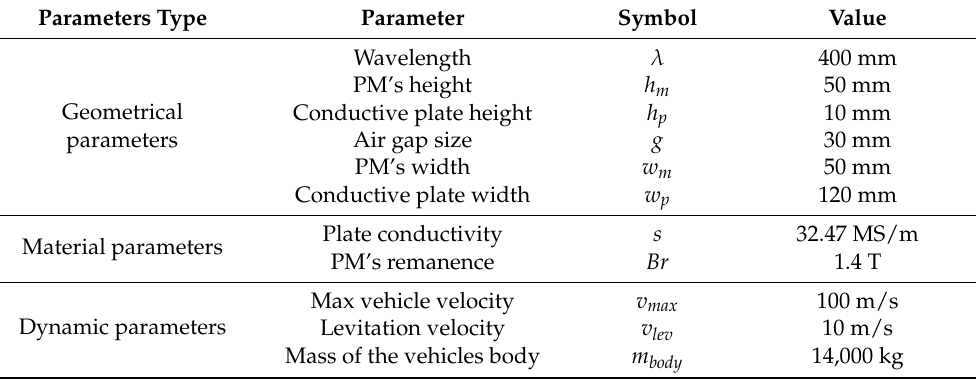
Table 1. Simulations’ geometrical, material and dynamic parameters with